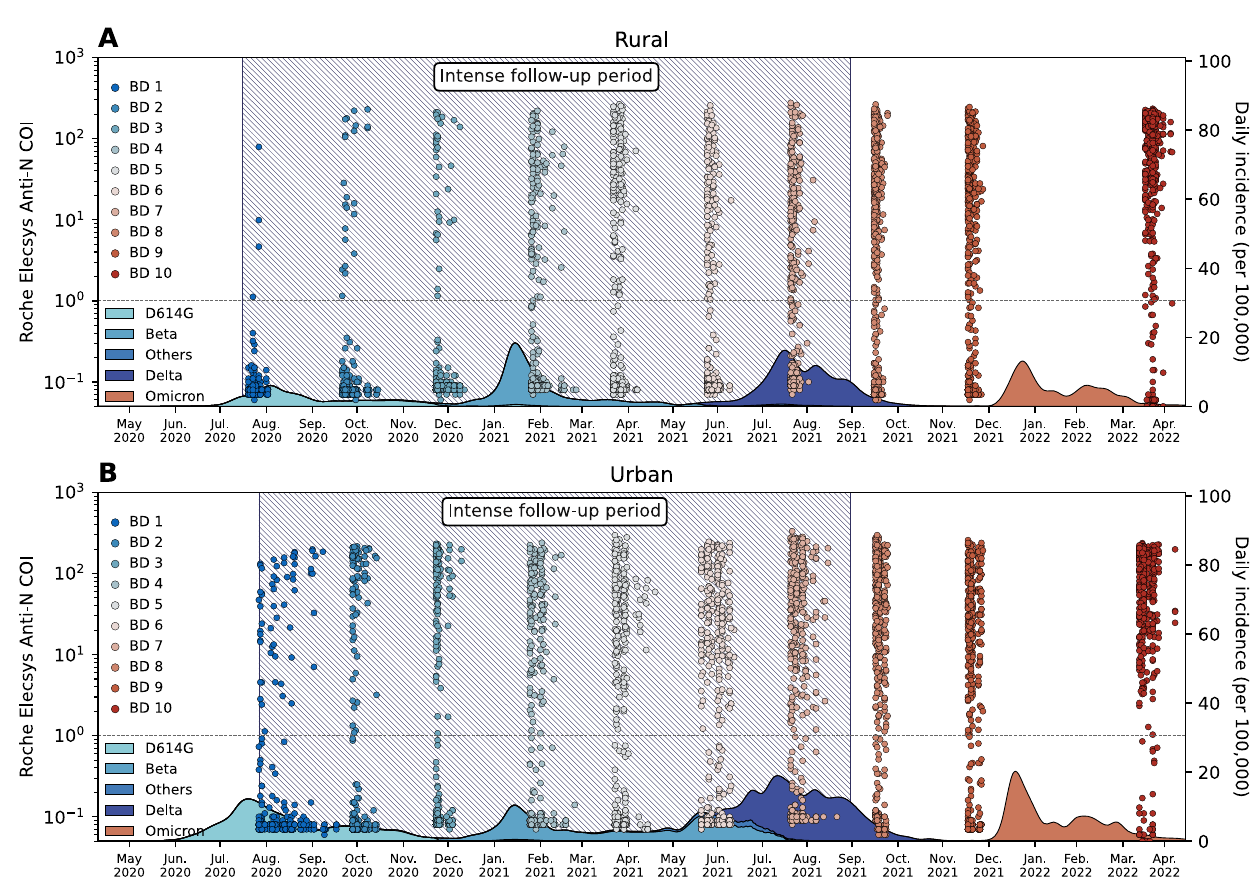
Fig. 1 | PHIRST-C study June 2020 – April 2022, SARS-CoV-2 serology and epi- demiologic curve in the two study sites. A Serum samples and epidemiologic curve in the rural site. Dots represent the Roche Elecsys Anti-SARS-CoV-2 nucleo- capsid assay cutoff index (COI) at different timepoints of the serum specimen col- lections; Each dot represents one serum specimen collection, with dot color denoting blood draw collection time, from blue (early) to red (late). The shaded curve at the bottom represents the daily incidence of SARS-CoV-2 cases in routine surveillance data collected from the Ehlanzeni District, Mpumalanga Province.